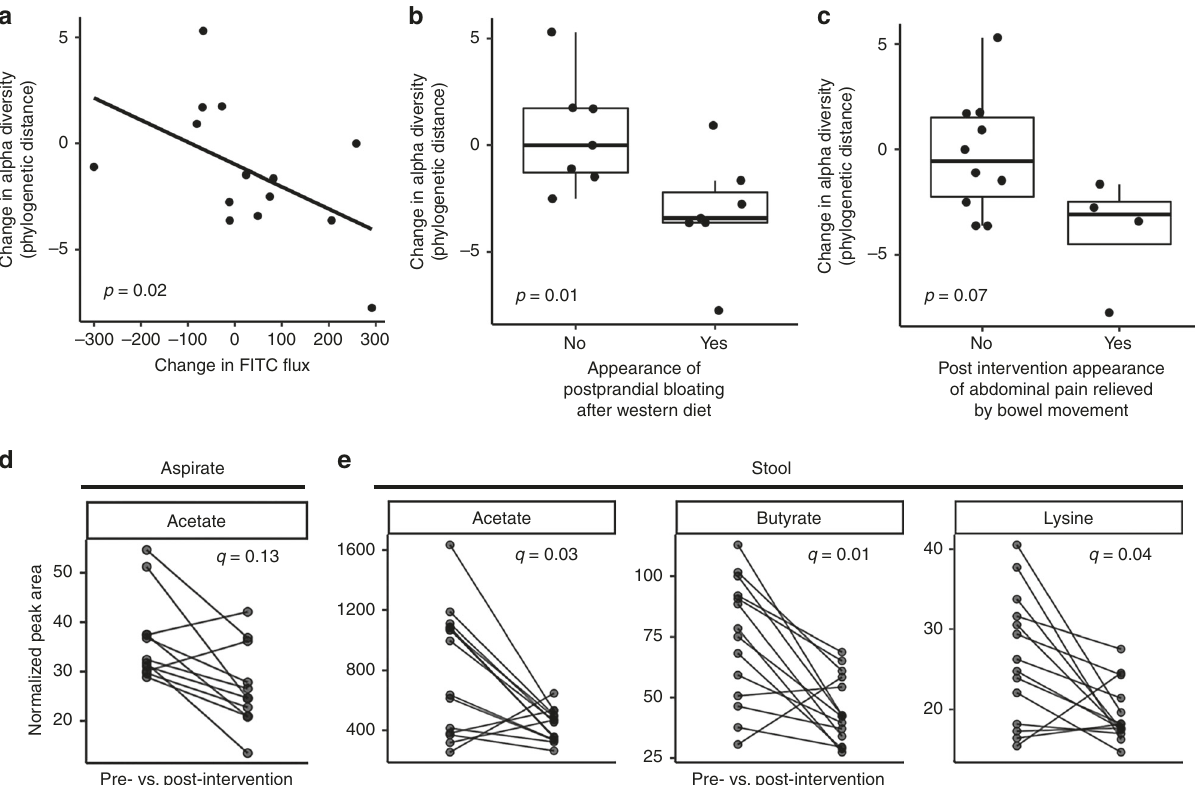
Fig. 6 Diet change is associated with changes in host physiology, microbial diversity, and metabolites. a Spearman correlation of change in alpha diversity (PD whole tree) and change in duodenal permeability measured by FITC fl ux across duodenal biopsy in an Ussing chamber ( n = 14, p = 0.02, rho = − 0.61, Spearman correlation). Association of change in alpha diversity (PD whole tree) with b postprandial bloating ( n = 14, p = 0.01, Mann – Whitney test) and c abdominal pain relieved by defecation ( n = 14, p = 0.07, Mann – Whitney test). Tukey boxplots show the median with IQR and 1.5 IQR whiskers. Change in d acetate ( n = 11, FDR q = 0.1, Wilcoxon signed rank test) in duodenal aspirates and e acetate ( n = 14, FDR q = 0.03, Wilcoxon signed rank test), butyrate ( n = 14, FDR q = 0.01, Wilcoxon signed rank test), and lysine ( n = 14, FDR q = 0.04, Wilcoxon signed rank test) in stool measured before and after